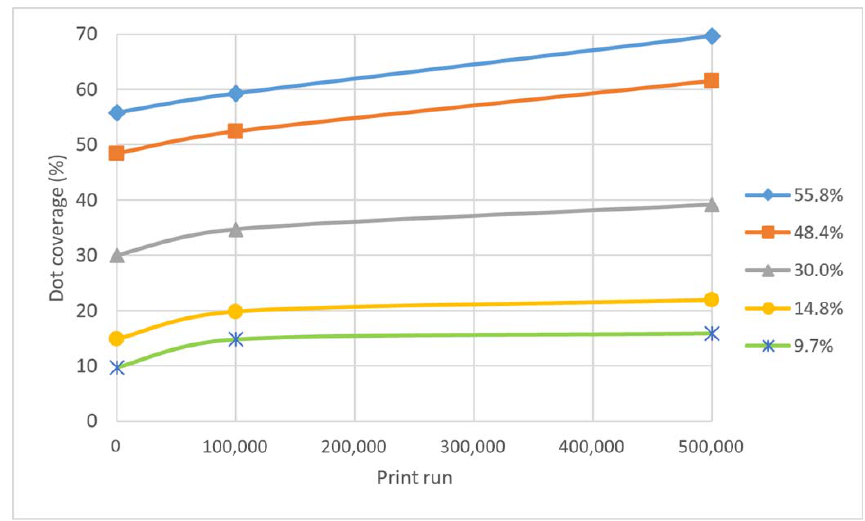
Figure 4. Dot coverage values of five selected halftone dots at three stages of printing.